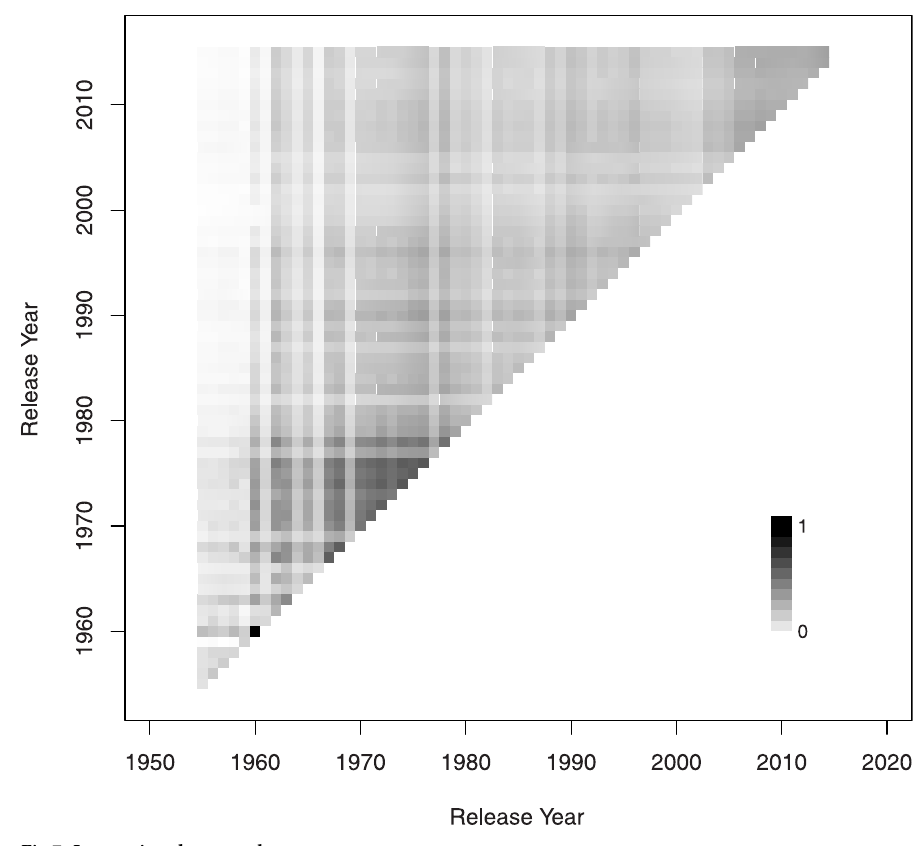
Fig 7. Interactions between the